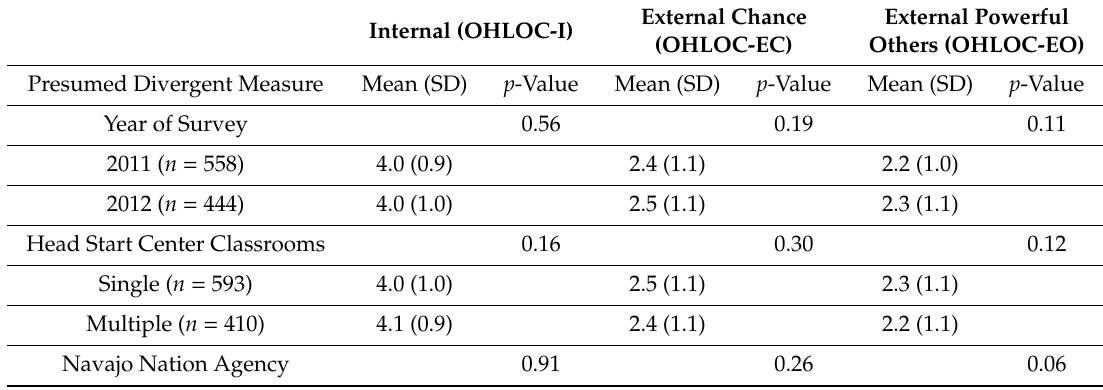
Table 5. Divergent validity—association between OHLOC subscale and each presumed divergent